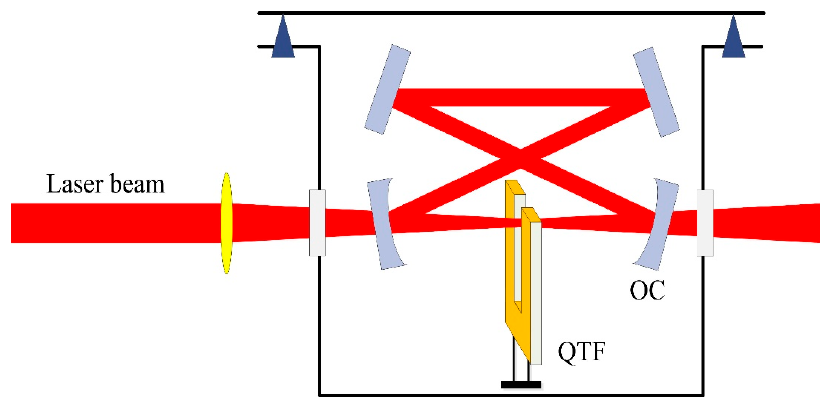
Figure 5. Schematic of the optical resonator.